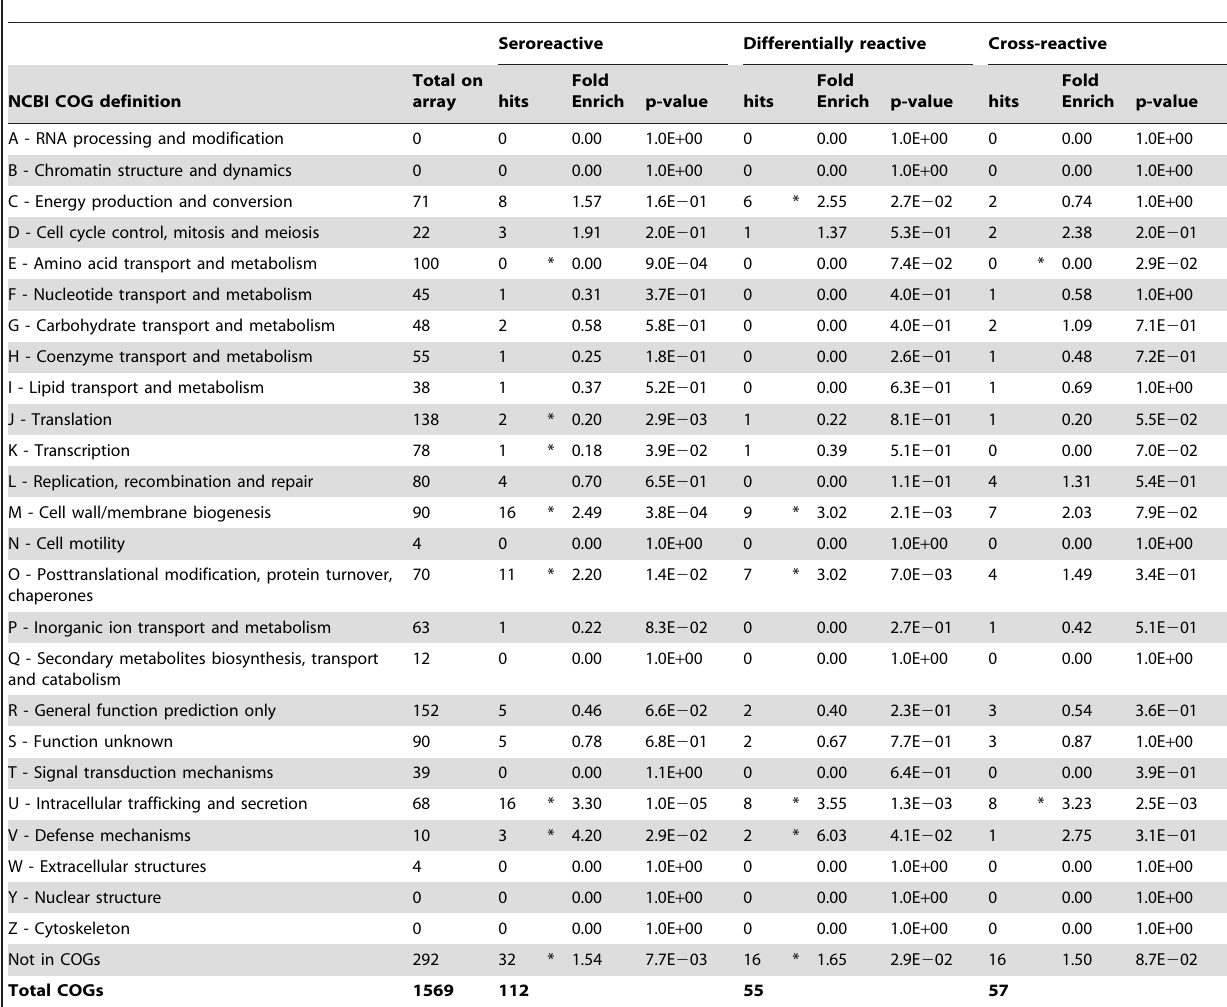
Enrichment table of COG functional groups for seroreactive, serodiagnostic, and cross-reactive antigens. The numbers of annotated proteins printed on the array for each COG are totaled under ‘‘Total on array.’’ Seroreactive, serodiagnostic, and cross-reactive annotated proteins are totaled as ‘‘counts’’. Asterisks denote significant values.